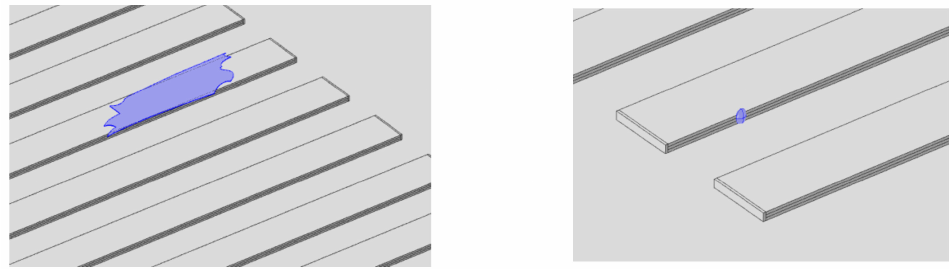
Figure 7. Schematic diagram of thermopile metal corrosion and particle